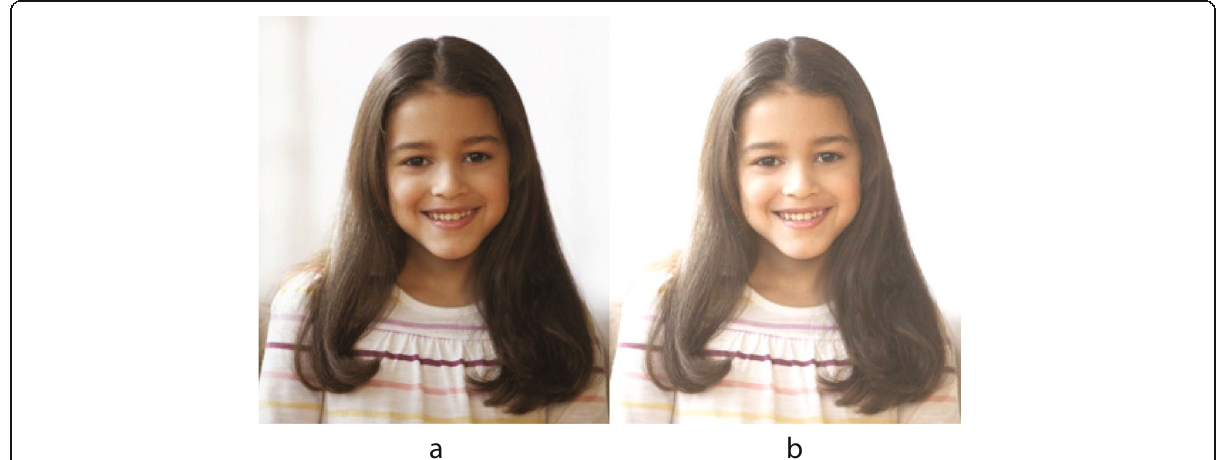
Fig. 6 Figure portraits non-photorealistic art processing result picture. a Figure portrait. b Non-photorealistic art processing result picture